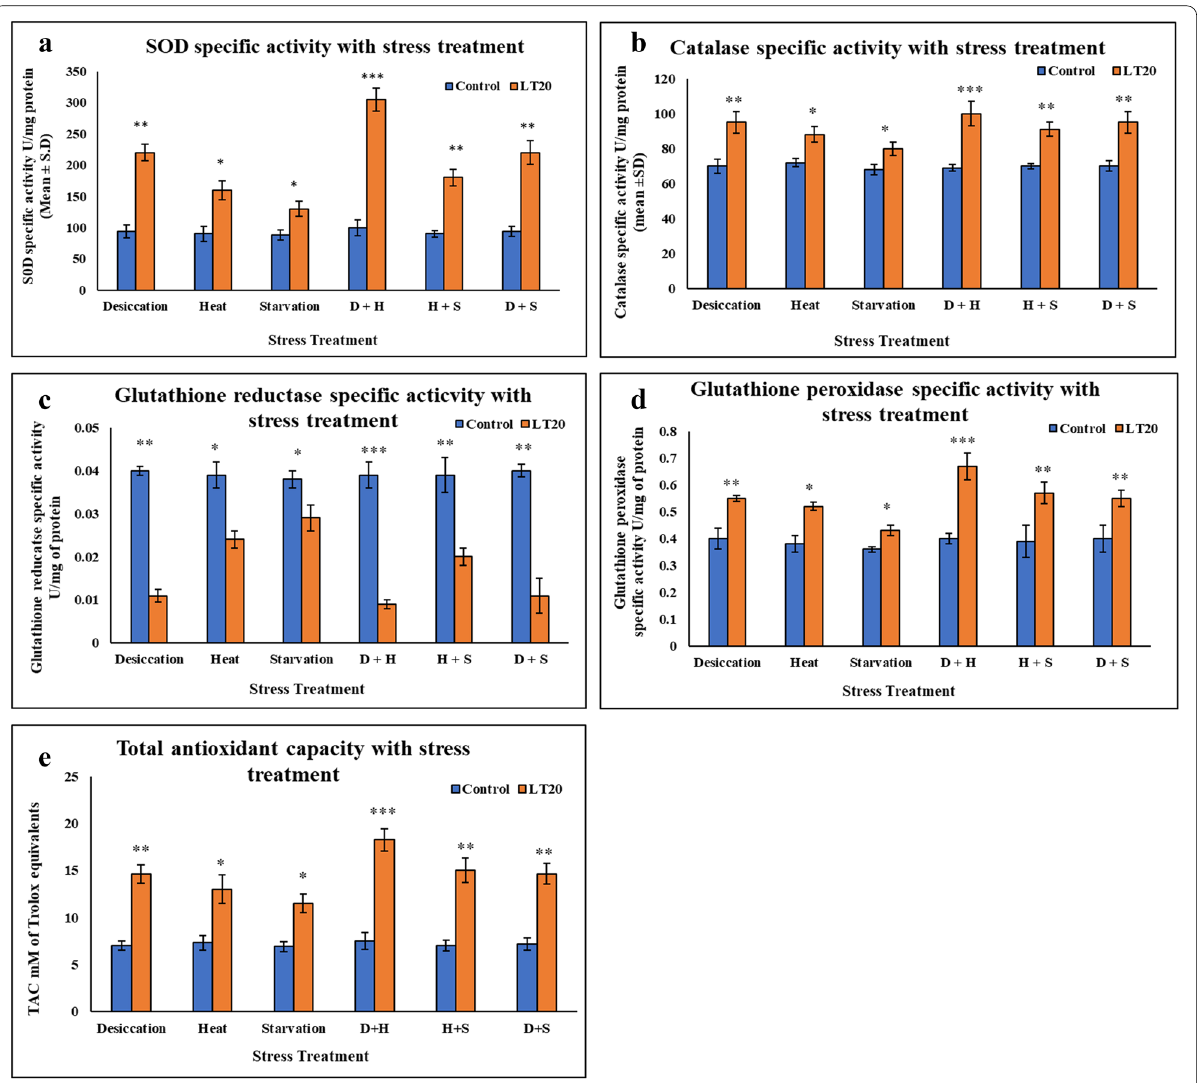
Fig. 7 Spectrophotometric measurement of antioxidant enzyme specific activity a superoxide dismutase (SOD) b catalase activity c glutathione reductase d glutathione peroxidase of the whole larvae of C. ramosus e Quantification of Total antioxidant capacity of the whole larvae of C. ramosus exposed to desiccation, heat, starvation, D ***P < 0.001; **P < 0.01; *P < 0.05 indicates significance